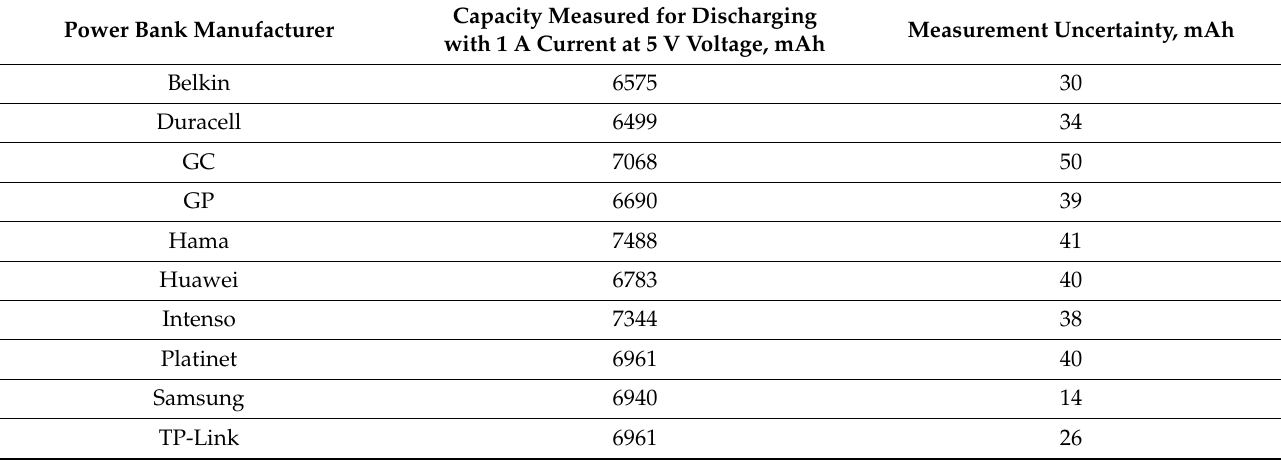
Table 3. Capacities of tested power